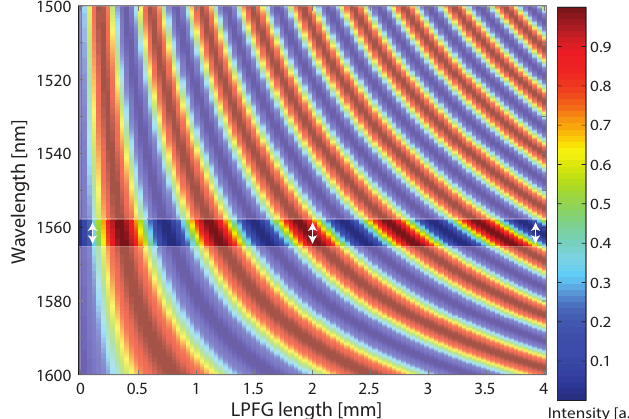
Figure 3. Spectral response of a LPFG with periodicity of 180 µ m as a function of the LPFG length. The results show that between 1559 nm and 1565 nm (denoted with white arrows), the light is excited to a high-order mode after 2 mm and then excited back to the Gaussian mode after another 2